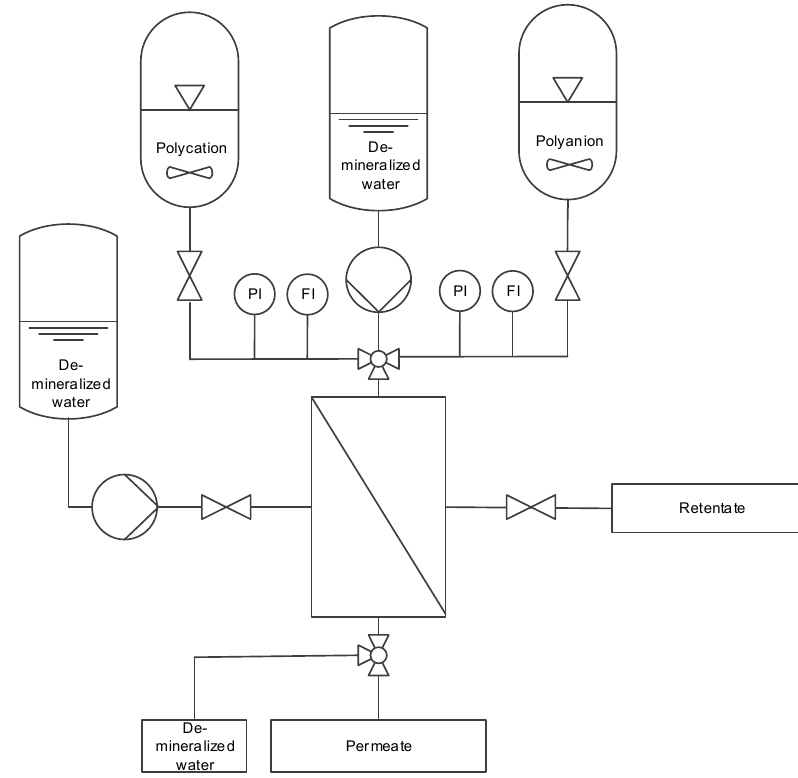
Figure 1. Flowchart of the coating process.